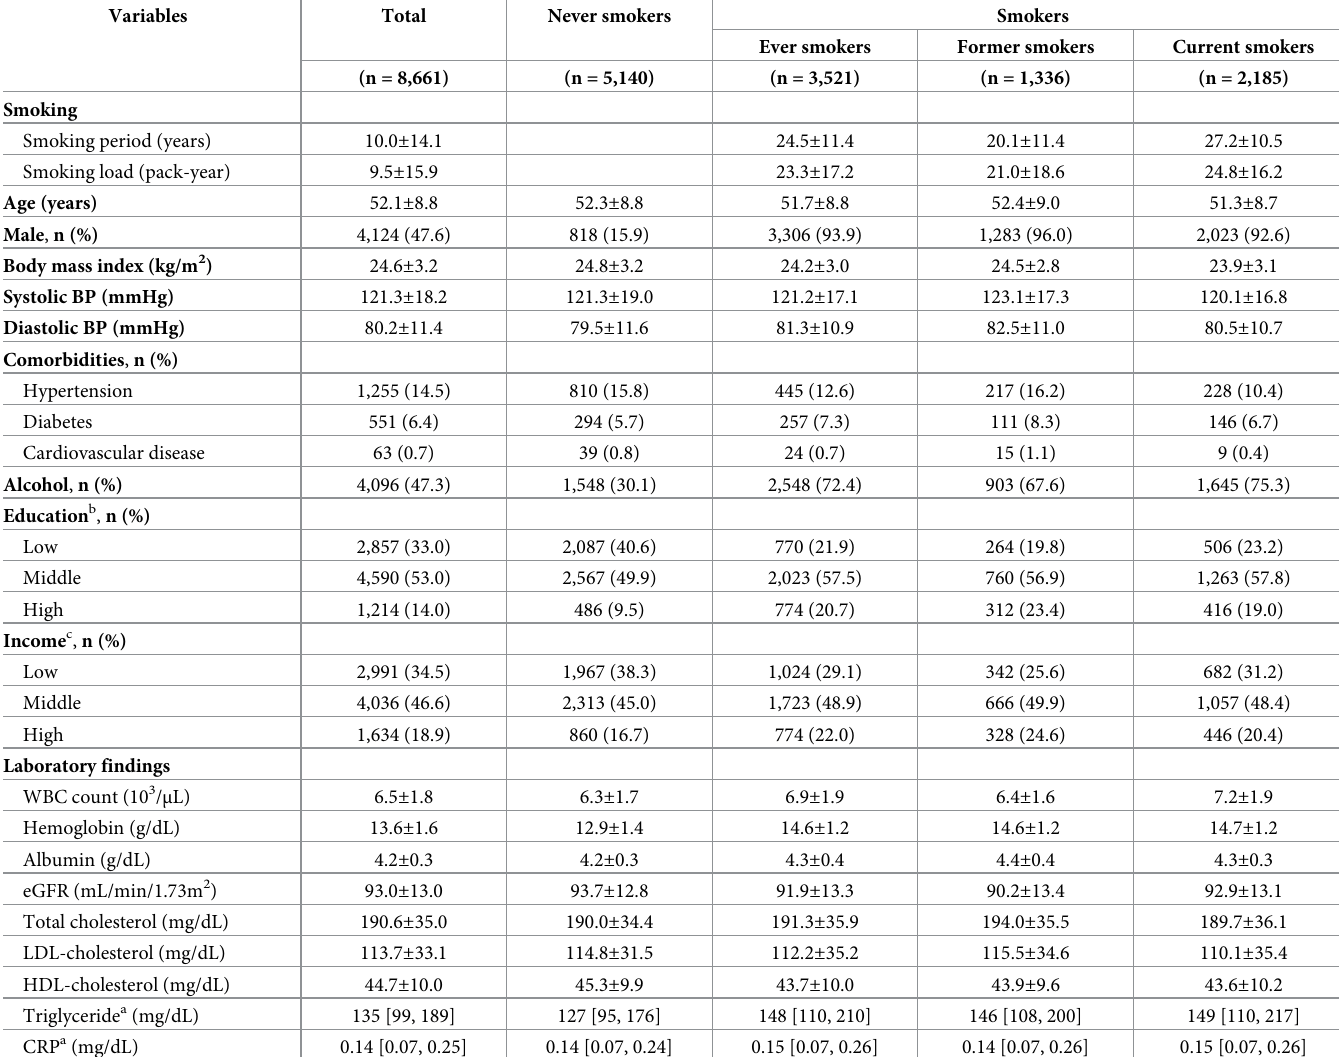
Table 1. Baseline characteristics of participants according to smoking